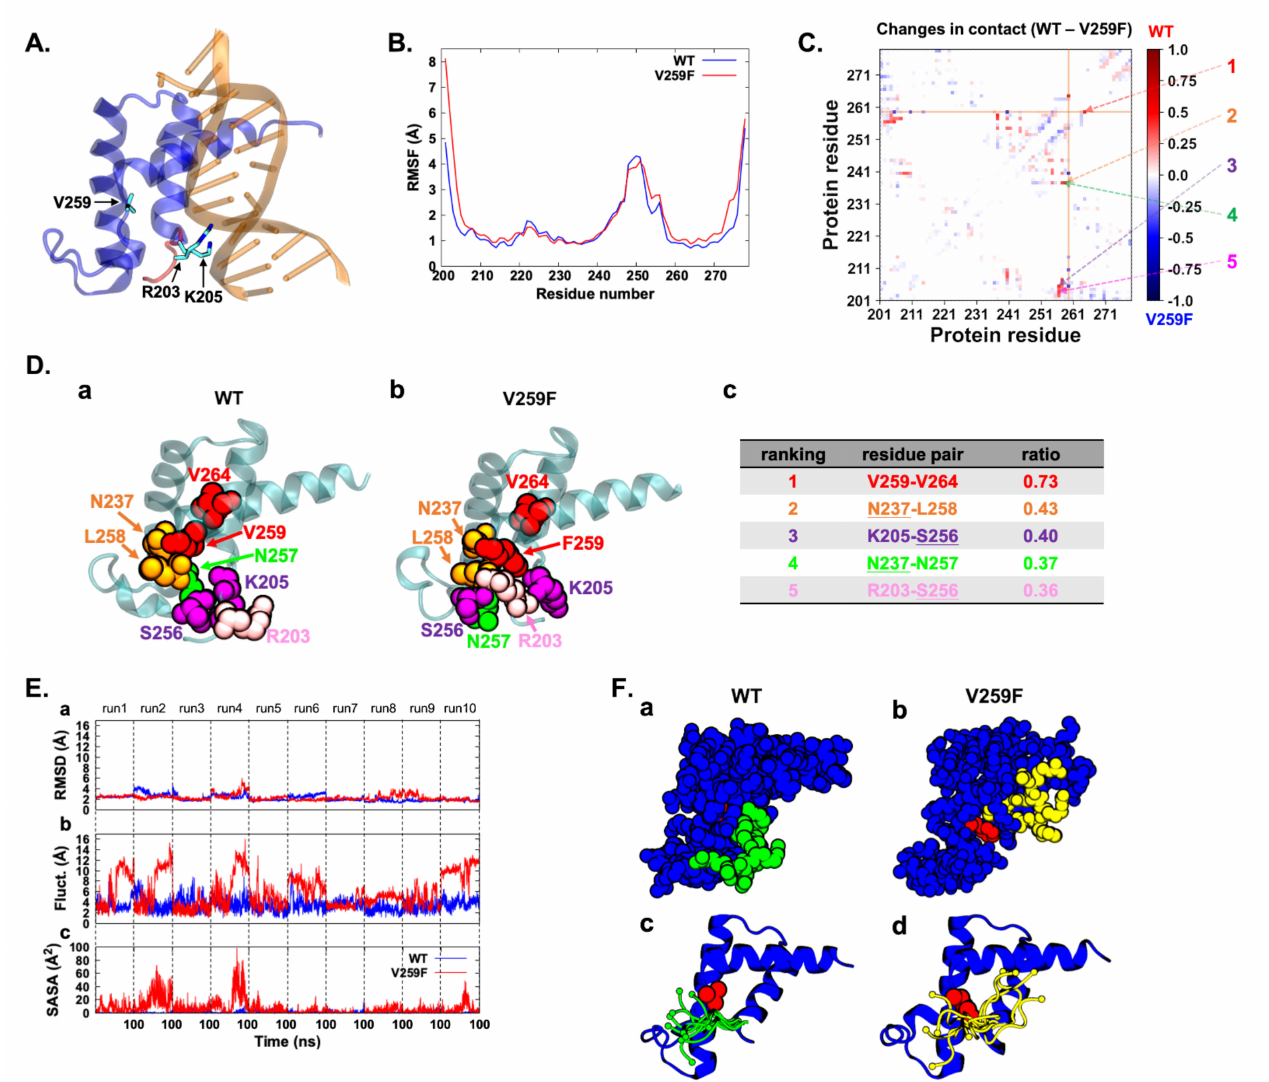
Figure 3. ( A ) X-ray crystallographic structure of the POUh domain (blue) binding with DNA (orange; PDB ID: 1IC8). The backbone of the N-terminal region is highlighted in red. The residues V259,